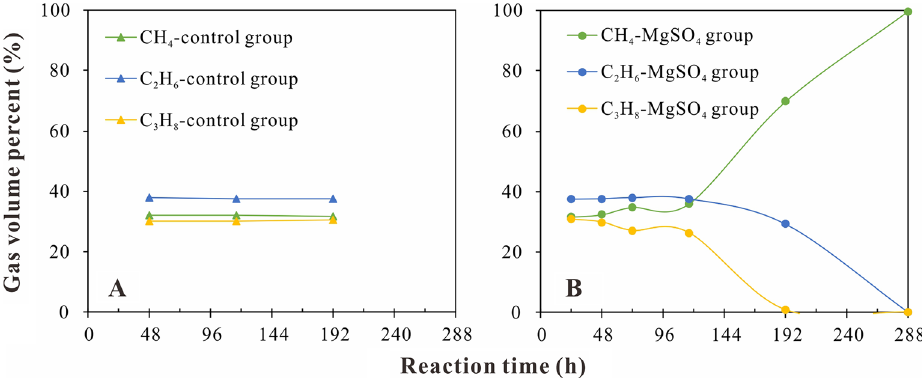
Figure 2. Plots of volume percentages of C 1 –C 3 alkanes versus reaction time for the control group ( A ) and the MgSO 4 group ( B